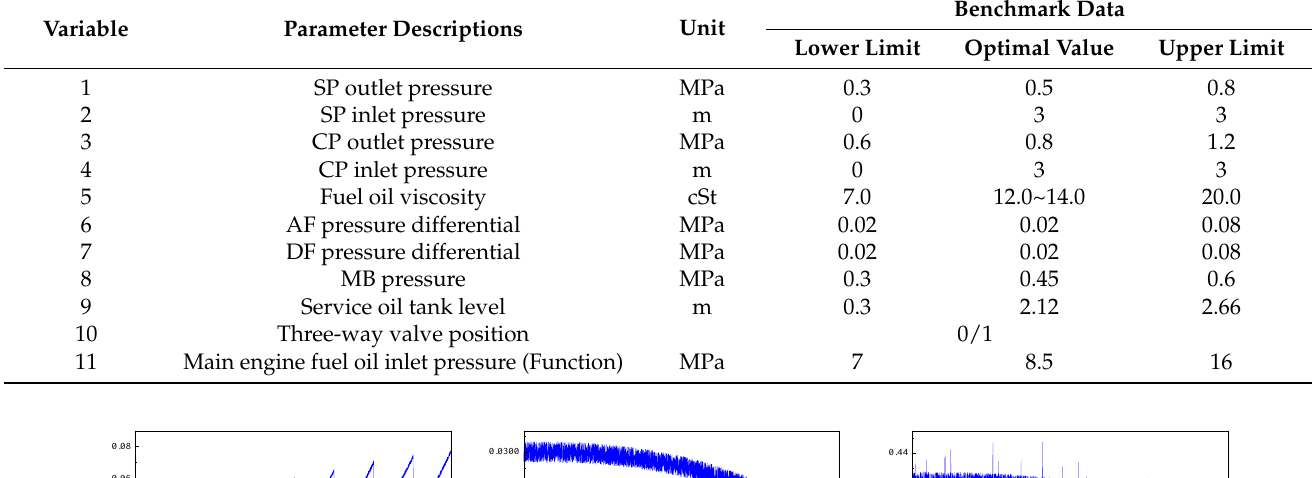
Table 1. Description of sensor data sets.